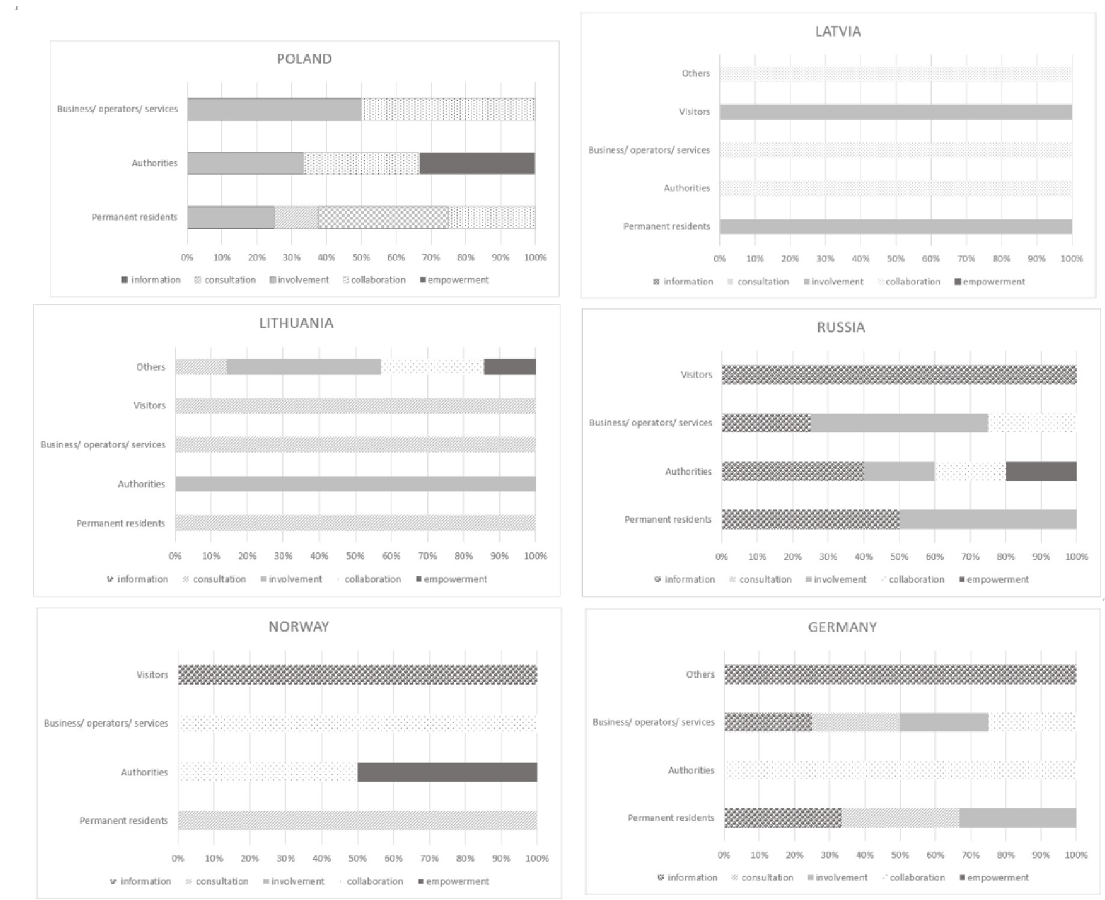
Fig 5. Engagement levels for key stakeholder clusters in six regions. Source: Own